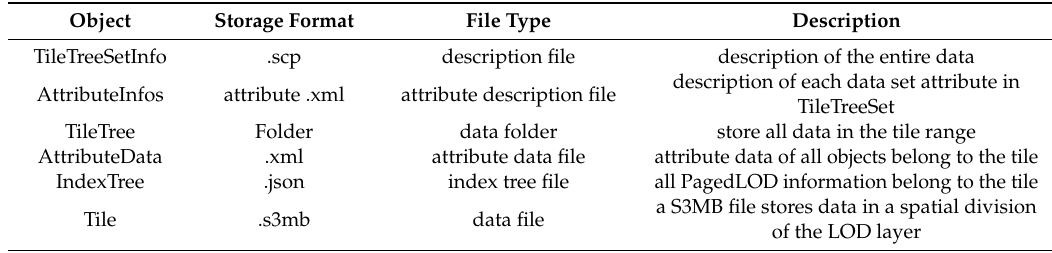
Table 3. The file organization of